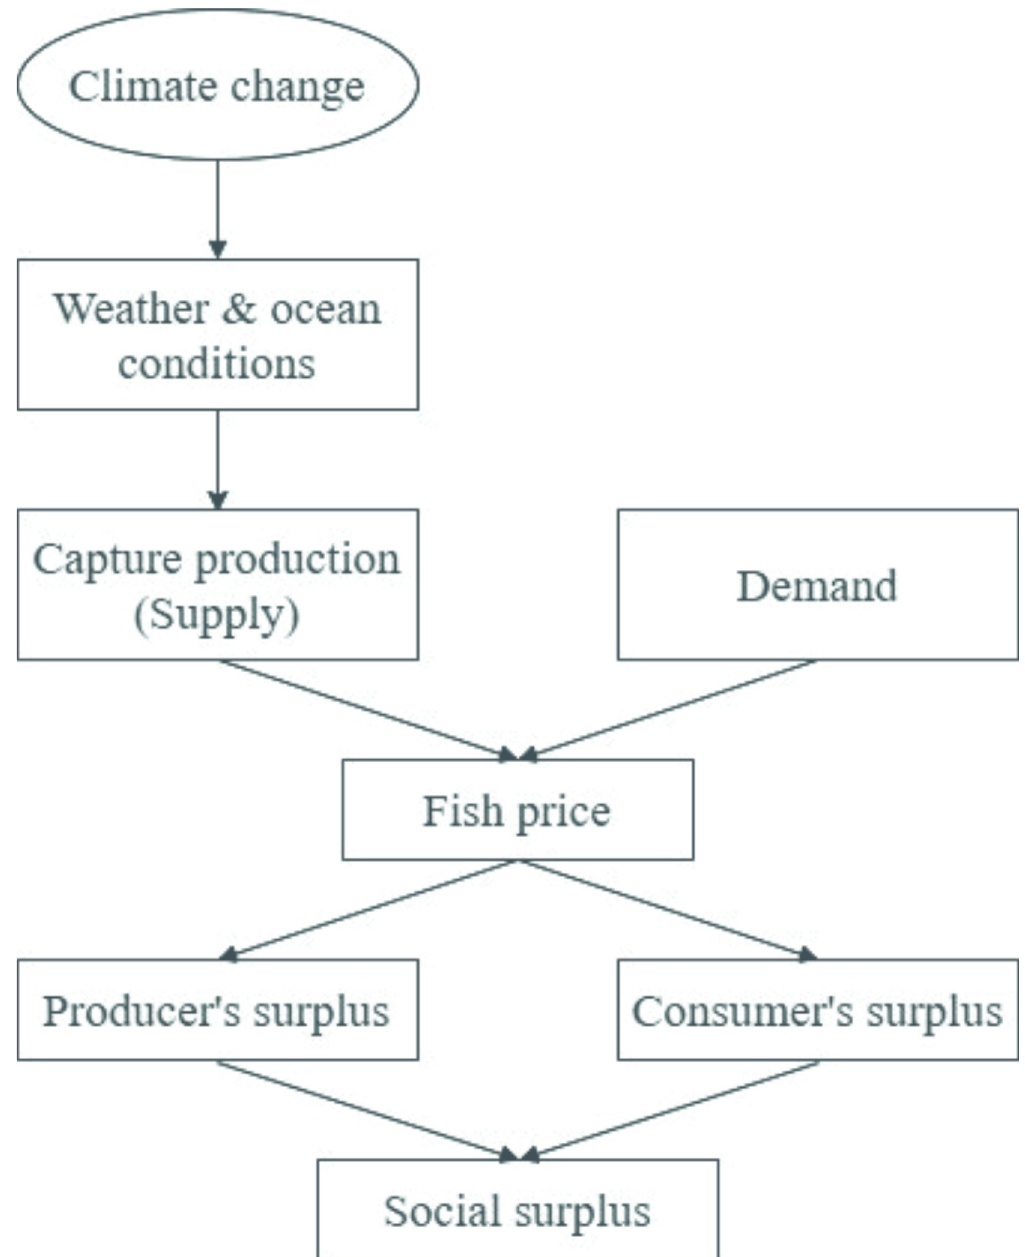
Fig 1. The welfare impact of climate change on fishery consumers and